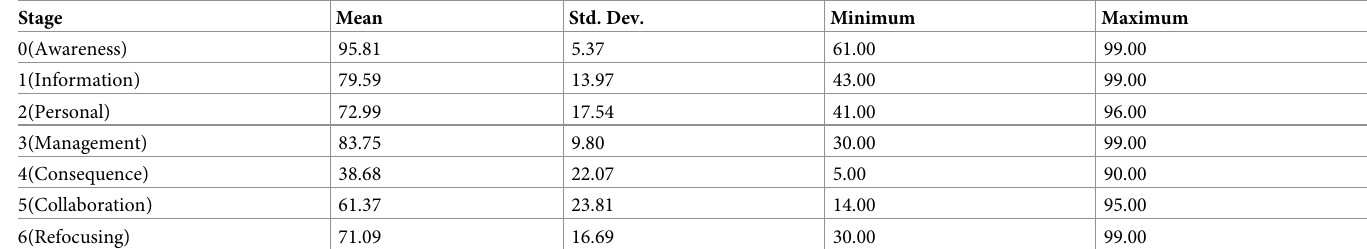
Table 4. Stages of concern statistics.